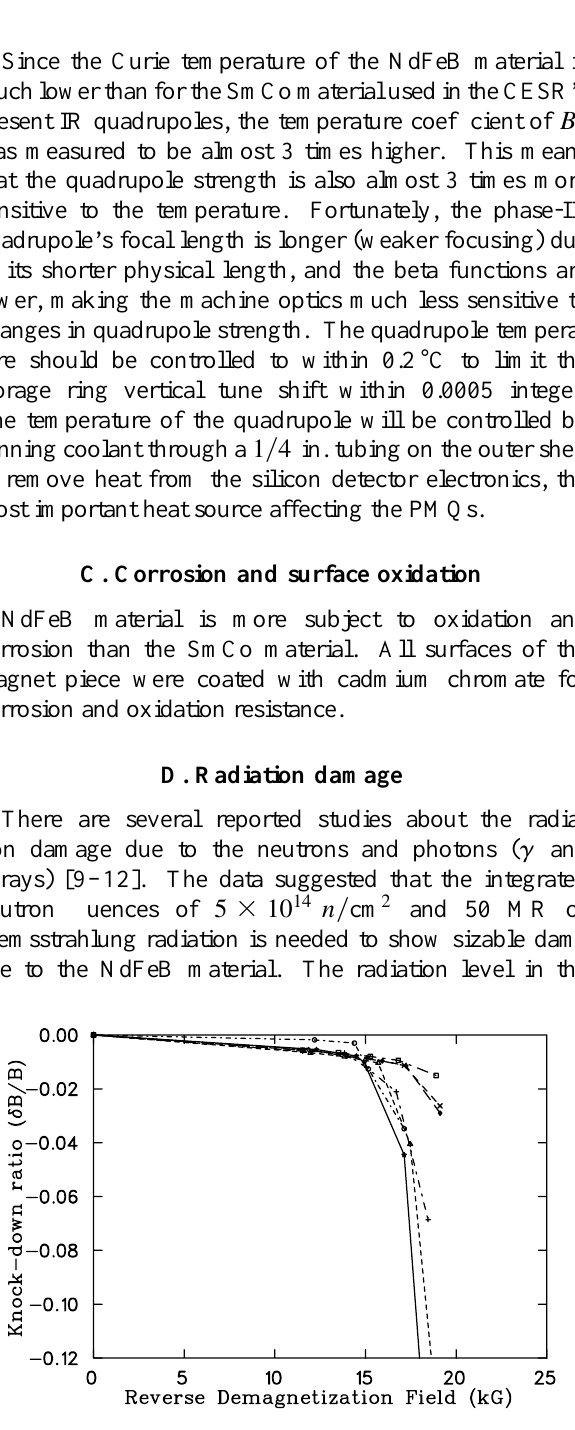
TABLE II. Measured quadrupole magnetic strength (each section is 9.2 cm long). (cid:114) (cid:105) (cid:114) (cid:111) Pole field at (cid:114) (cid:105) Integrated strength k cm cm kG kG (cid:45) cm (cid:121) cm Front section